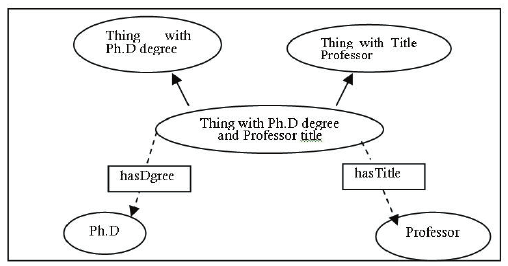
Fig. 4. Semantic enriched graph-based ontology represen-